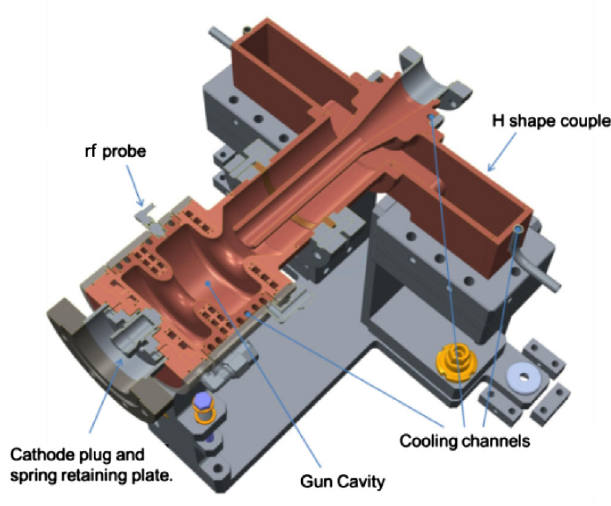
FIG. 14. Cavity design of the 400 Hz photoinjector.